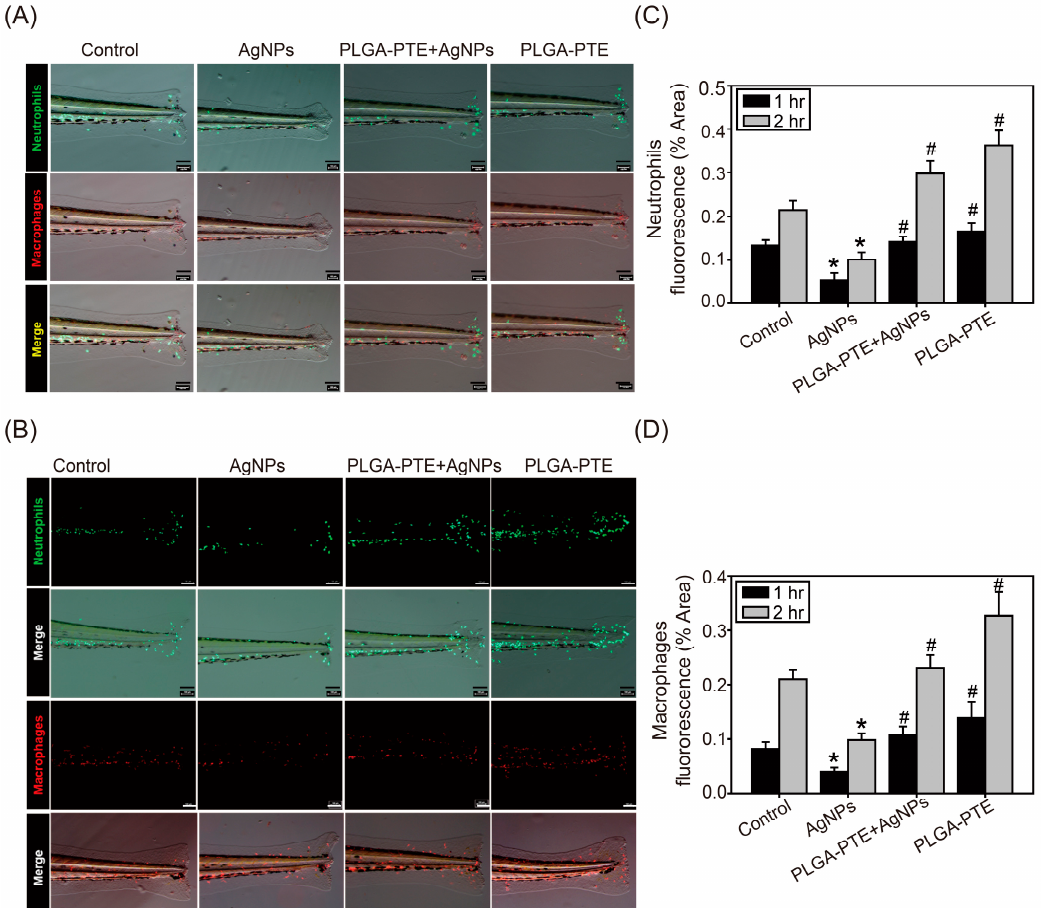
Figure 7. AgNPs exposure affected the accumulation of neutrophils and macrophages in the wounded tail. Zebrafish embryos after exposure to control, 0.3 μ g/mL AgNPs, PLGA-PTE + AgNPs, and 0.3 μ g/mL PLGA-PTE for 120 h. After the transgenic zebrafish Tg(mpx:eGFP):Neutrophils and Tg(mpeg1:mCherry):Macrophages were anesthetized, their tail fins were transected at the end of the spinal cord with a sterile blade under a microscope. The reverse migration of the immune cells was observed under a fluorescence microscope after ( A ) 1 h and ( B ) 2 h of transection. Scale bar= 100 μ m. The image was quantified as ( C ) and ( D ) and the presented is representative of three independent experiments ( n = 3). * p < 0.05, AgNPs groups versus control groups; # p < 0.05, PLGA-PTE + AgNPs versus AgNPs groups.